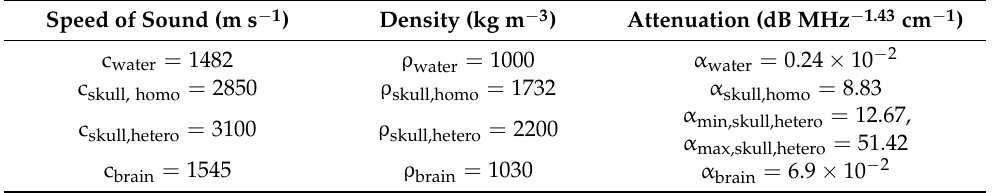
Table 1. Acoustic parameters